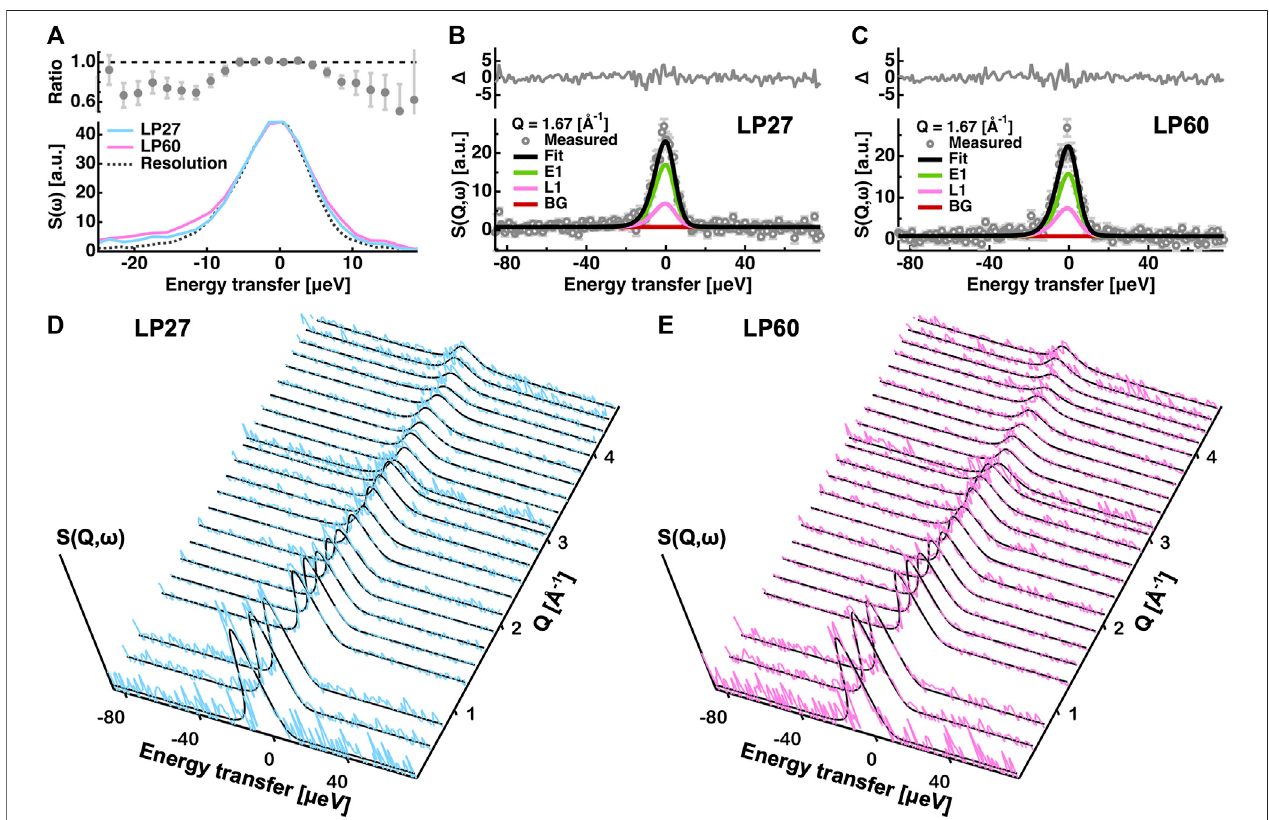
FIGURE 2 | Analysis of the QENS spectra. (A) : Comparison of the QENS spectra integrated over all the Q-range measured. Those of LP27 and of LP60 are denoted bycyanandmagentalines,respectively.Theresolutionfunctionisrepresentedbyadottedline.Intheupperpanel, theintensityratioofLP27toLP60isshown. (B,C) :Examplesofthe fi ttingoftheQENSspectraatQ (cid:2) 1.67[Å − 1 ]ofLP27 (B) andLP60 (C) .Experimentaldatapointsaredenotedbygreyopencircles.Thetotal fi t(Fit), the elastic component (E1), the Lorentzian function (L1), and the background (BG) are denoted by black, green, magenta, and brown lines, respectively. In the upper panel, the residuals ( Δ ) between the measured and the fi tting values are shown. Error bars are shown in light grey. (D,E) : Comparison of the obtained QENS spectra and the corresponding fi ts at all the Q values measured for LP27 (D) and LP60 (E) . The experimental QENS spectra in (D,E) are shown in cyan and magenta, respectively. The fi ts are shown by black